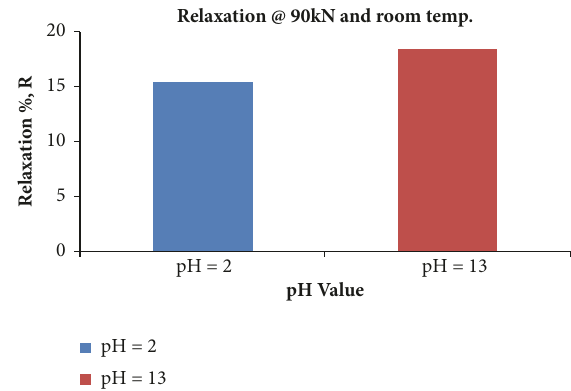
Figure 10: Combined effect of stress/load and environment on relaxation.